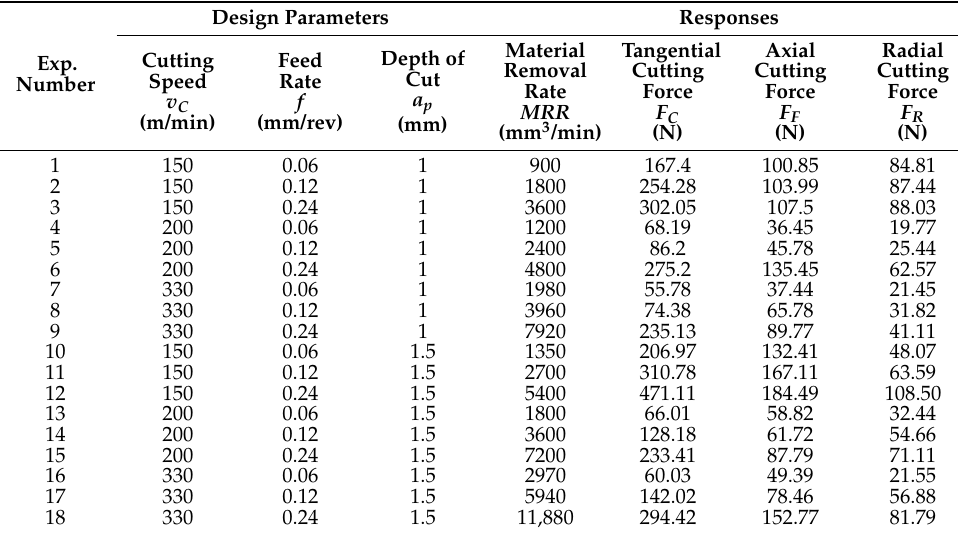
Table 3. Full factorial experimental design and